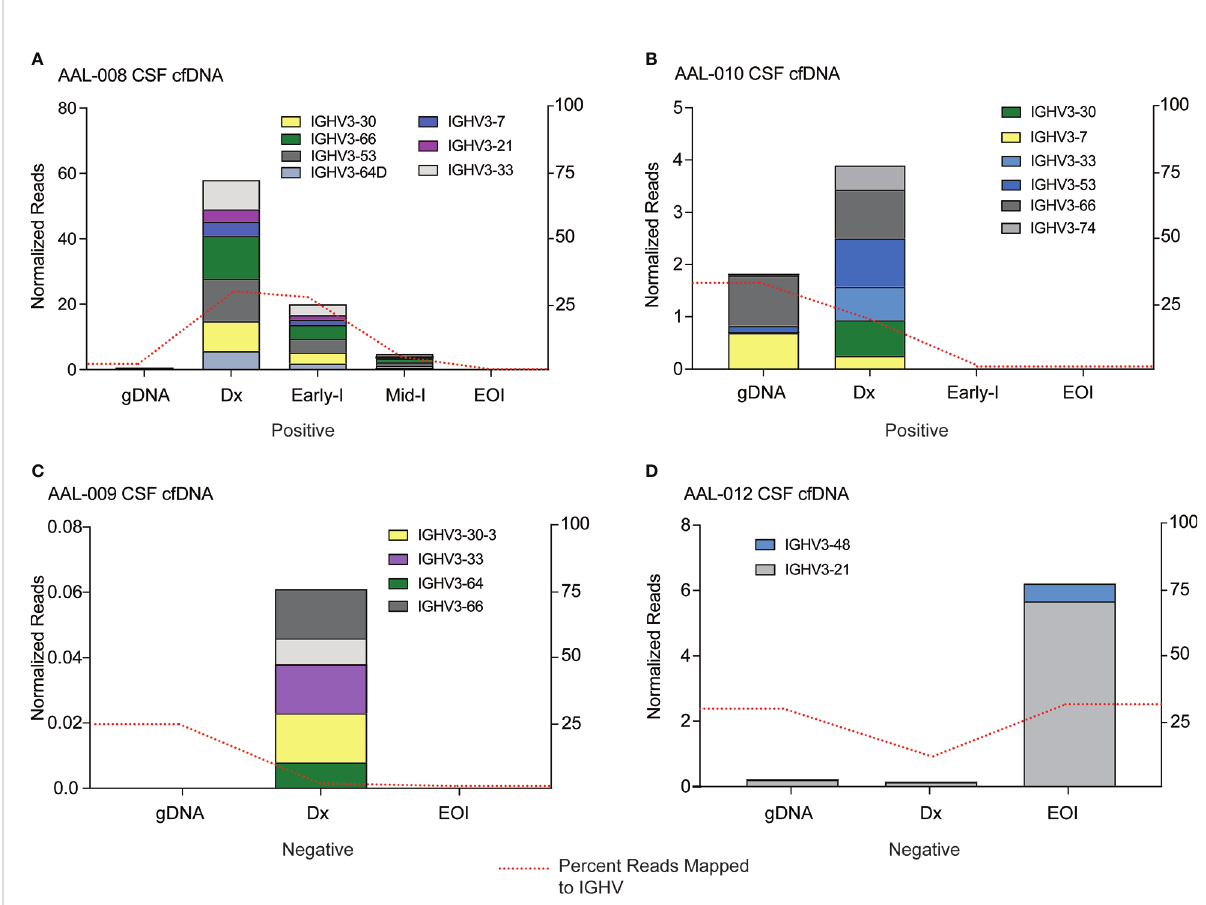
FIGURE 5 IGHV sequencing can detect cfDNA in the cerebrospinal fl uid of B-ALL patients. cfDNA was extracted from CSF samples of four patients, IGHV regions were PCR ampli fi ed, and resultant libraries were sequenced using MinION. Data were analyzed using Galaxy. Clones in the genomic DNA (gDNA) of bone marrow biopsy and cell-free DNA (Dx) CSF samples at diagnosis that comprised at least 5% of total reads were tracked across all timepoints. Clone abundance is normalized to total mapped reads per library, shown on the left axis. The percentage of reads aligned to the IGHV region on Chr14 (red dashed line) is a relative indicator of leukocyte abundance at each timepoint/sample and is shown on the right axis. Patients in (A) and (B) were clinically diagnosed as CNS positive by fl ow cytometry, indicating in fi ltration of B-ALL cells into the CNS. Patients (C) and (D) were diagnosed as CNS negative, although IGHV reads from cfDNA were detectable in the CNS